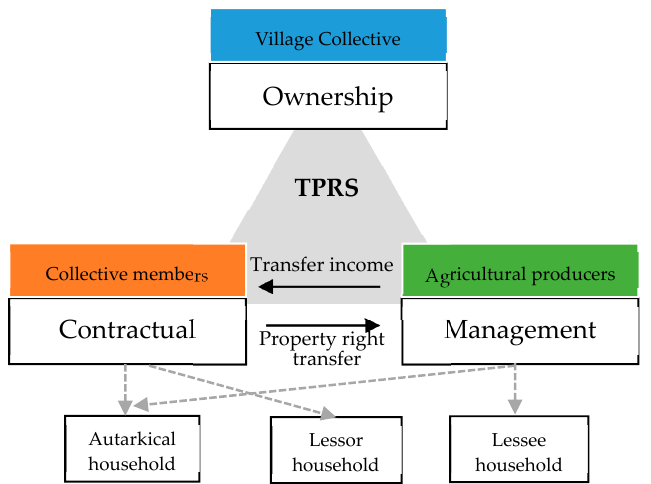
Figure 2. The possession status of farmland property rights among rural households under the TPRS system.